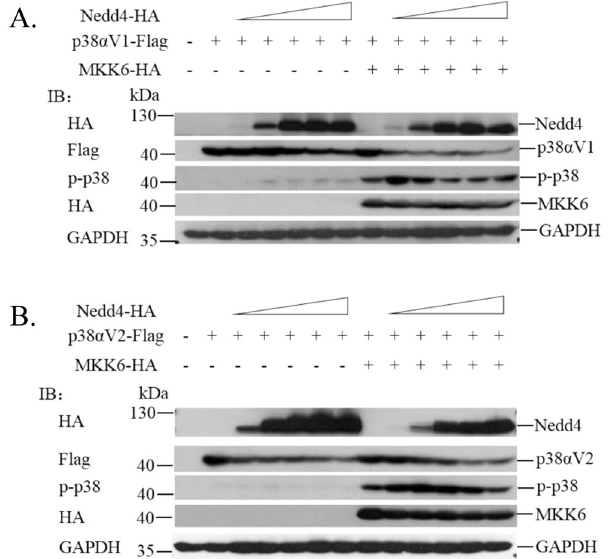
Figure 7. Nedd4 promotes degradation of p38 α V1 and p38 α V2. Immunoblots analysis of lysates of 293T cells co-transfected equivalent amounts of p38 α V1-Flag ( A ) or p38 α V2-Flag ( B ) and MKK6-HA plus increasing amounts of HA-Nedd4. Meanwhile, pcDNA3.1( + ) empty vector was being added to ensure the same total amount of plasmids in each sample ( A , B